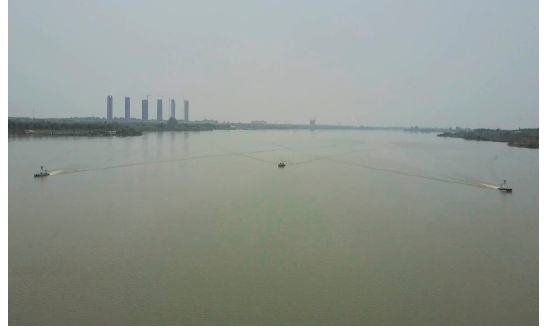
Figure 29. Jellyfish formation in cruising.